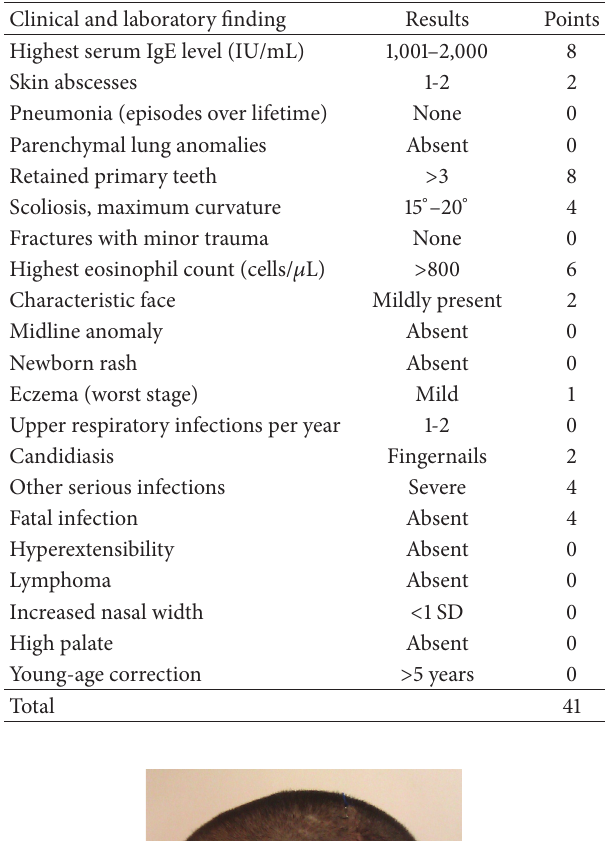
Table 1: Assessment by NIH scoring system with clinical and laboratory tests [4].